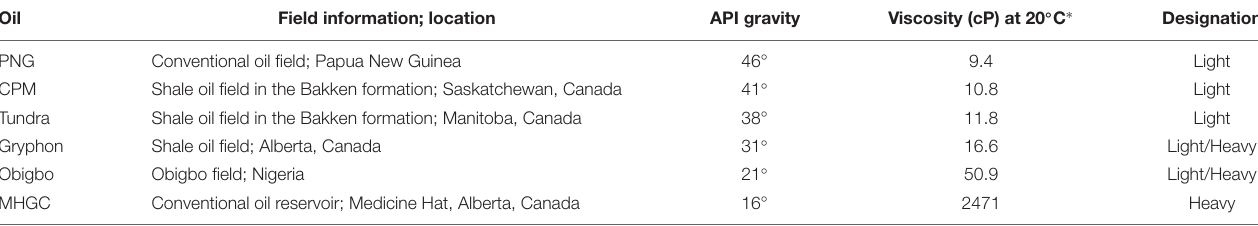
TABLE 1 | Physicochemical properties of oil samples used in this study.